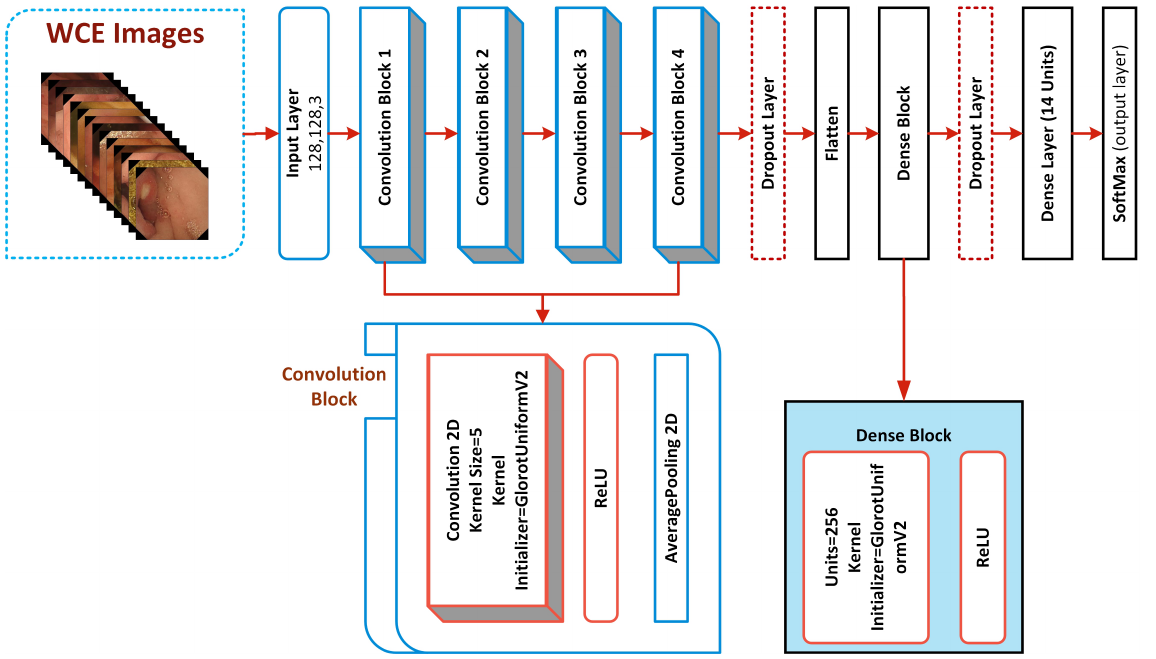
Figure 4. Detailed architecture of robust deep CNN to classify gastric